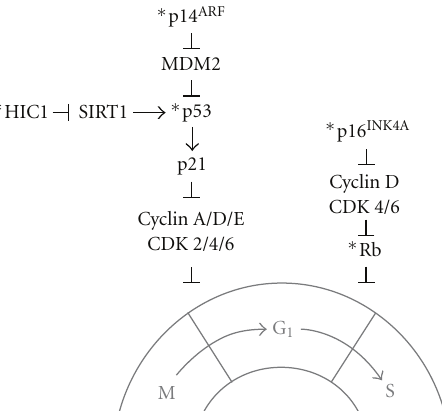
Figure 1: Schematic model of epigenetic events that regulate cell cycle progression in osteosarcoma. The cell cycle regulators Rb, p53, p16 INK4A , p14 ARF , and HIC1 have been found to be hypermethylated at the gene promoter in osteosarcoma ( ∗ ). These alterations may contribute to dysregulation of cell cycle control (loss of the G1 checkpoint) and may promote tumor